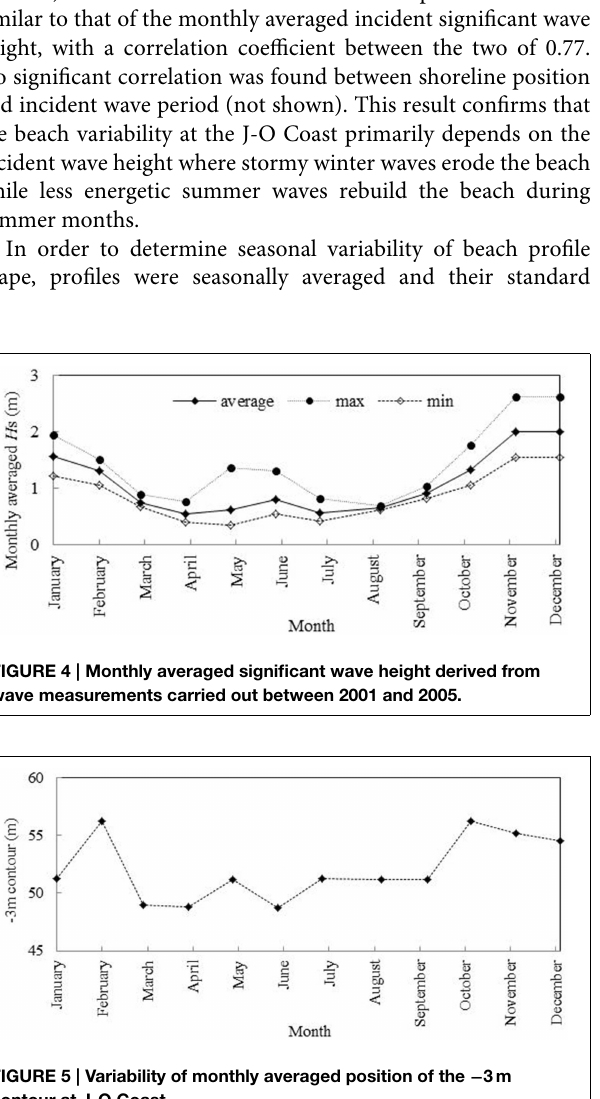
FIGURE 7 | Average annual beach profiles at J-O Coast from 1987 to